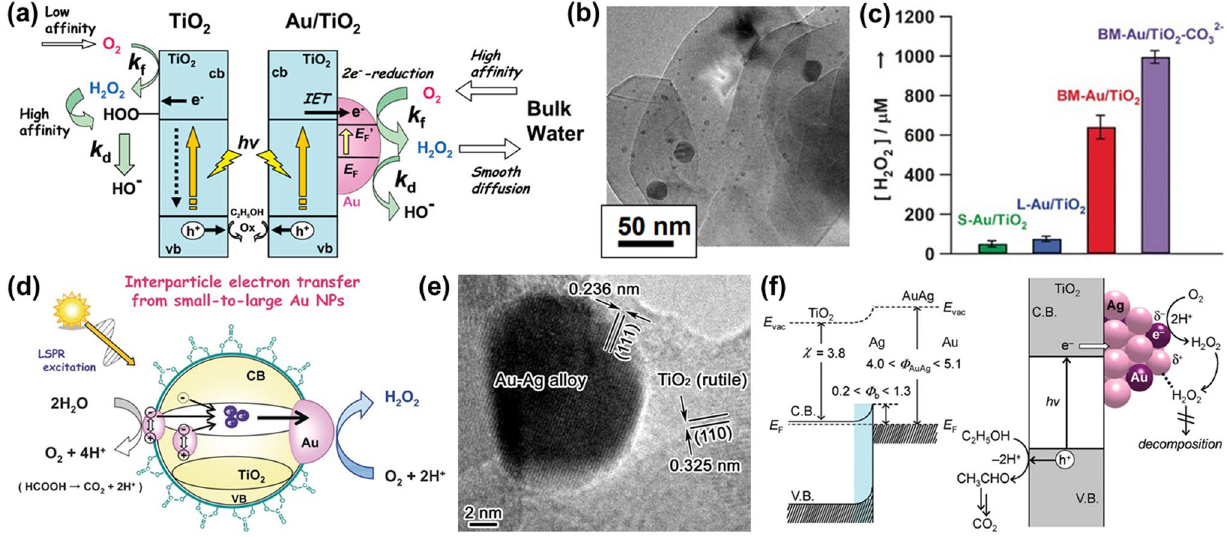
Fig. 7 a Mechanism of the H 2 O 2 formation over the Au/TiO 2 photocatalyst. Reproduced with permission from Ref. [133]. Copyright 2010 American Chemical Society. b TEM image of the BM-Au/TiO 2 photocatalyst. c Photocatalytic H 2 O 2 production on various photocatalysts. d Proposed mechanism of the BM-Au/TiO 2 -CO 32− plasmonic catalyst in the photocatalytic H 2 O 2 generation. Reproduced with permission from Ref. [135]. Copyright 2016 Wiley–VCH Verlag GmbH & Co. KGaA, Weinheim. e HRTEM image of the Au 0.1 Ag 0.4 /TiO 2 photocatalyst. f Sche- matic energy-band and mechanism of the H 2 O 2 production on the AuAg/TiO 2 photocatalyst. Reproduced with permission from Ref. [139]. Cop- yright 2012 American Chemical